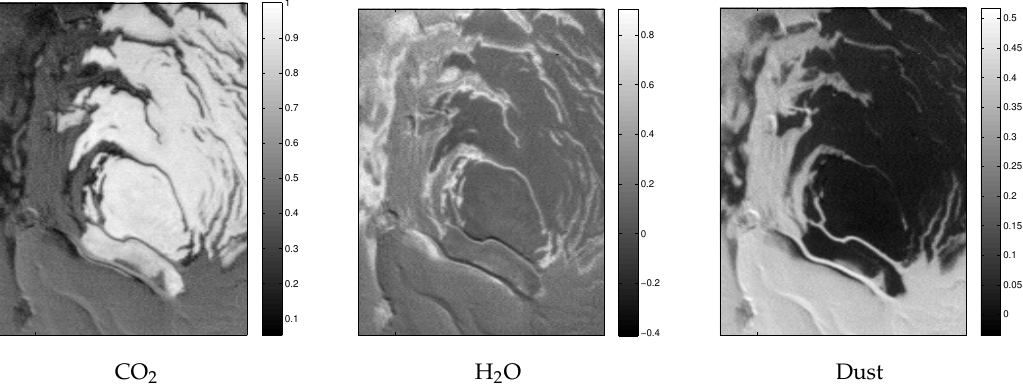
Figure 7. The abundances of the CO 2 , H 2 O and dust endmembers obtained by the state-of-the-art unmixing method presented in [31].